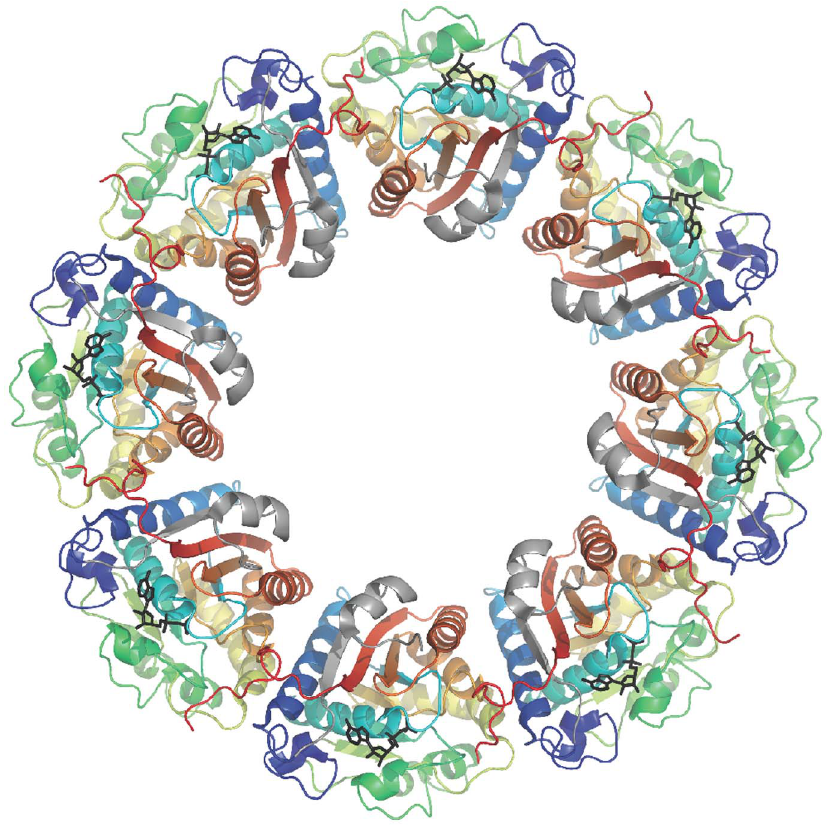
Figure 1. The CapA1B2 octameric ring. The octameric structure of the non-phosphorylated CapA1B2(K55M) mutant protein in complex with ADP-Mg [16] (PDB ID 2VED) is represented as cartoon. In each subunit, the a A- b A elements from CapA1 are colored in grey and the CapB2 moiety is colored by spectrum from blue to red. The bound nucleotides are highlighted as black sticks.